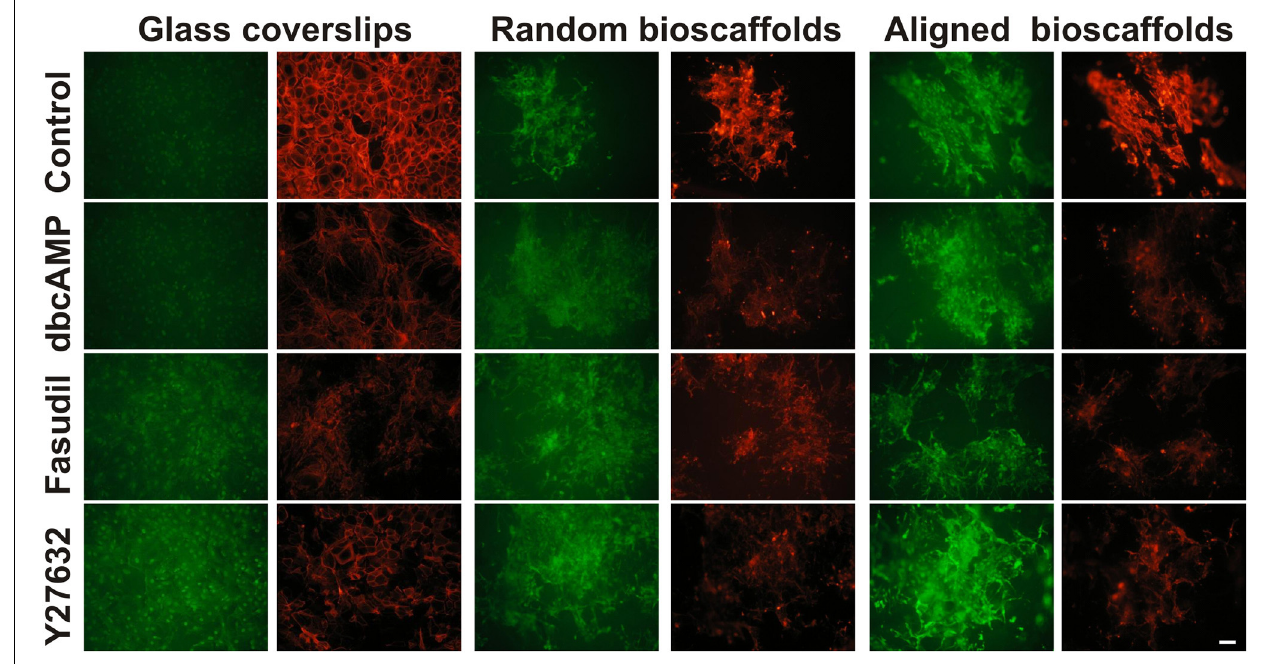
FIGURE 2 | Effect of drug treatments on expression of G-actin and F-actin in astrocytes cultured on different substrates. Astrocytes were treated for 72h with vehicle (Control), dbcAMP (1mM), Fasudil (100 μ M) or